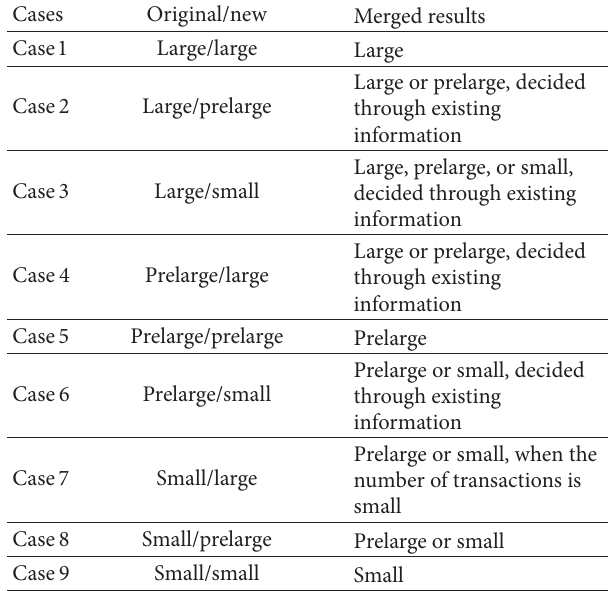
Table 1: Nine cases and their results for transactions insertion based on the pre-large